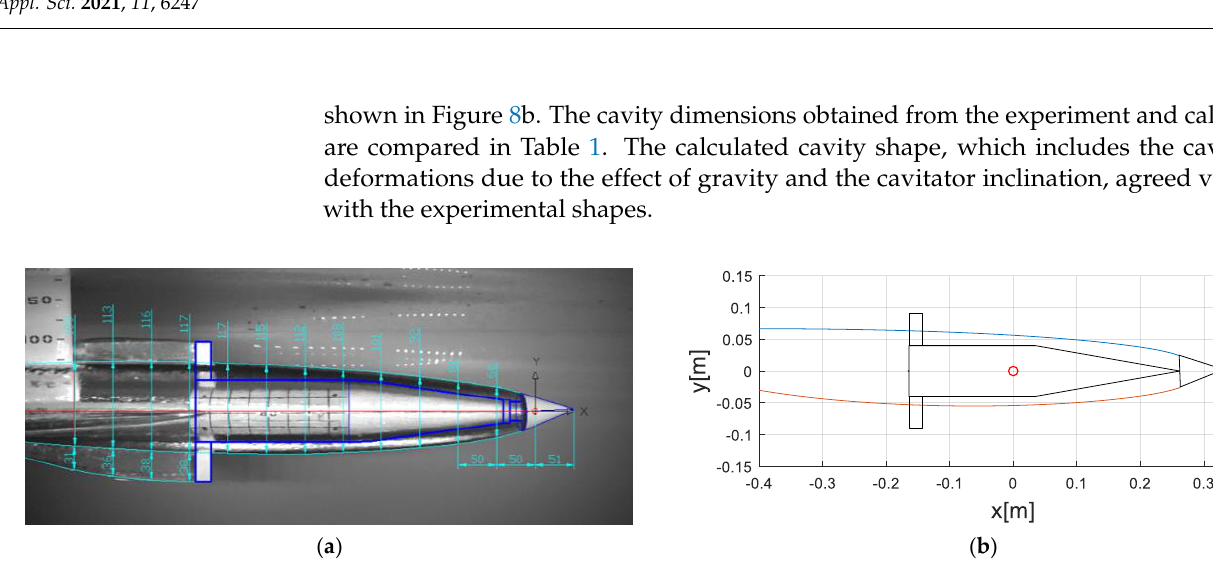
Figure 8. Experimental and calculated cavity shapes at a fixed zero trim angle: ( a ) experiment; ( b ) calculation. Table 1. Comparison of the cavity dimensions obtained from the experiment and calculation. Section No.